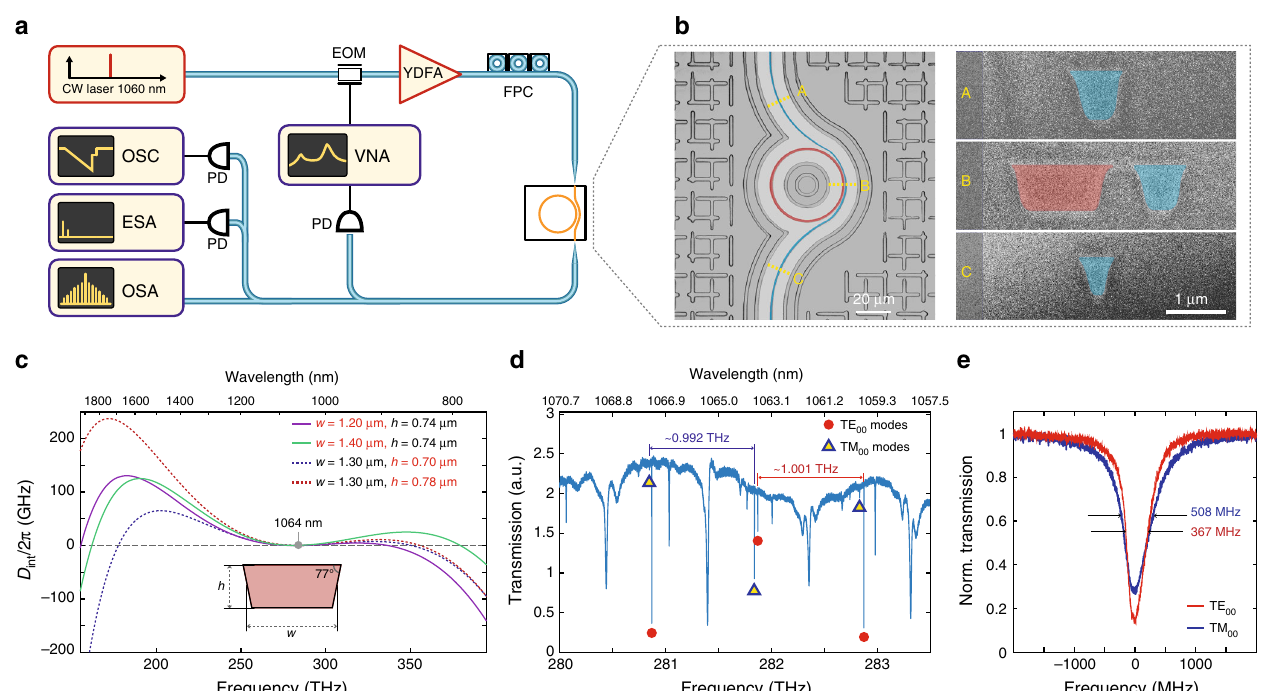
Fig. 1 Si 3 N 4 microresonators for soliton frequency comb generation in the NIR. a Set-up schematic used for dissipative Kerr soliton generation and characterisation: a tunable external-cavity diode laser with a centre wavelength of 1050 nm is used as a seed, YDFA – ytterbium-doped fi bre ampli fi er, FPC – fi bre polarisation controller, VNA – vector network analyser, EOM – electro-optical phase modulator, PD – photodiode, OSC – oscilloscope, ESA – electrical spectrum analyser, OSA – optical spectrum analyser. b Left: optical microscope image of the 1-THz microring resonator (highlighted in red) with a pulley-style bus waveguide (blue). Right: scanning electron microscope images of the resonator and bus waveguide cross sections obtained via focused ion beam cuts at different positions (A – C) marked on the left image. c Simulated integrated dispersion pro fi les ( D int /2 π ) for TM 00 mode of resonator waveguides having different heights of 0.70, 0.74 and 0.78 μ m, widths of 1.2, 1.3 and 1.4 μ m and fi xed sidewall angle of 77° (see more details on dispersion engineering in Supplementary Note 1). d Transmission trace of the 1-THz microresonator shown in ( b ). The two fundamental mode families (TE 00 and TM 00 ) can be distinguished based on their free spectral ranges (0.992 THz for TM 00 and 1.001 THz for TE 00 ), and are marked with red and blue shapes correspondingly. Other resonances correspond to higher order modes with comparably lower Q -factors. e Linewidth measurements of the fundamental mode families. The frequency axis was calibrated using a fi bre-loop cavity. Typical loaded linewidth of the modes is ~400MHz for TE 00 and ~500 MHz